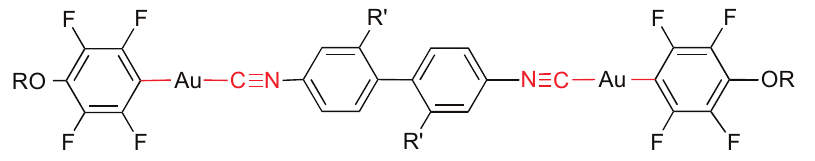
H , n = 4, 6, 8, 10, R ' = H, Cl, n 2 n +1